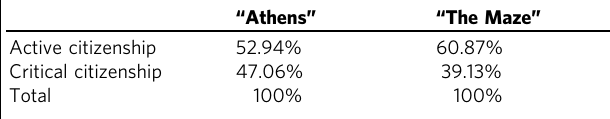
Table 3 Comparative coding